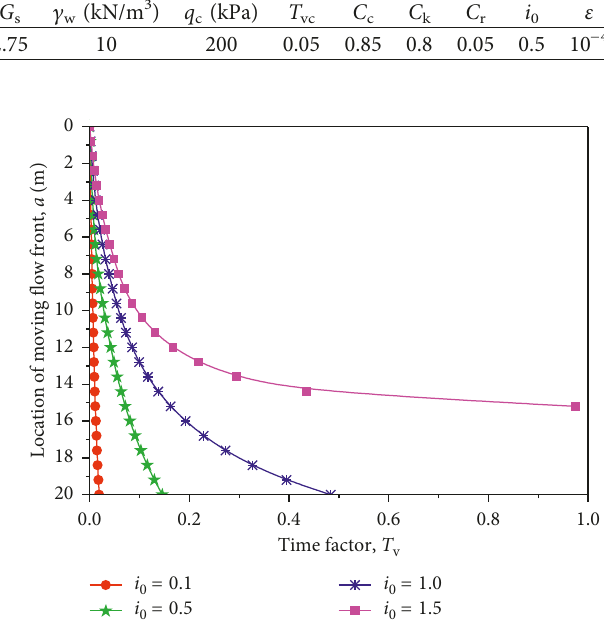
Figure 6: Influence of i 0 on the moving flow